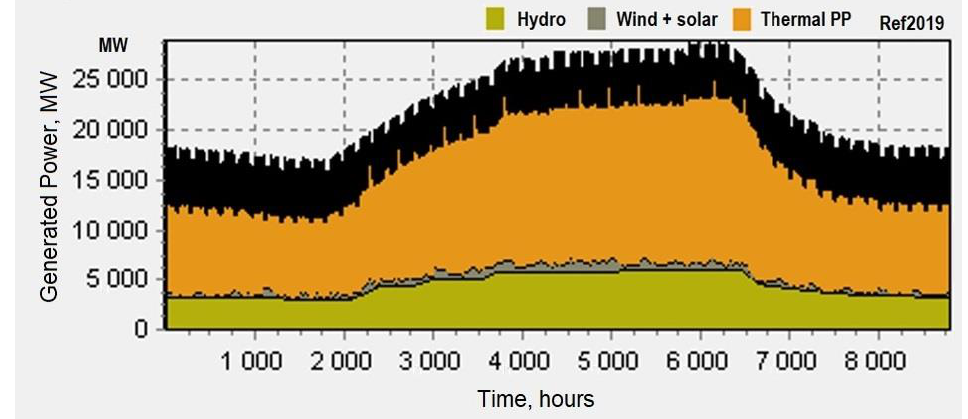
Figure 5. Ref2019. Electricity demand and production in 2019 according to EnergyPLAN.